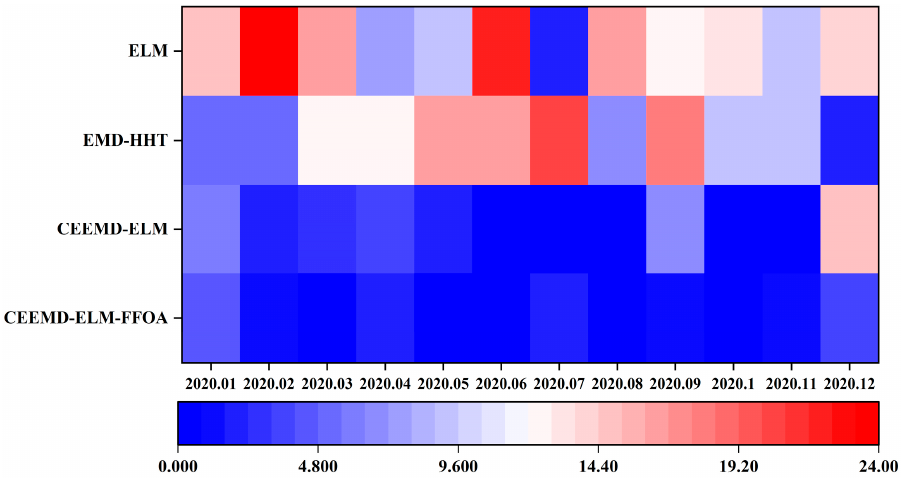
Figure 10. Hot spots of prediction errors of different models. Table 4. Comparison of evaluation indexes of di ff erent models.